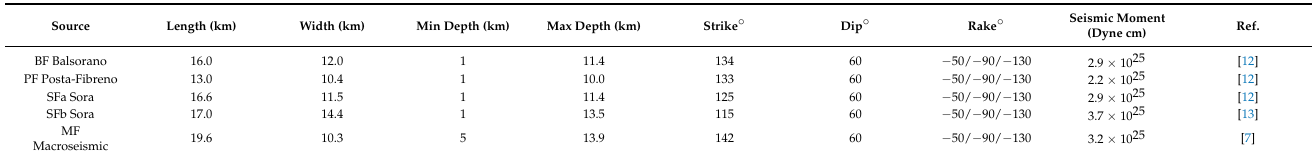
Table 1. List of the five potential sources of the 1654 earthquake that represent the input to the modeling of the coseismic static